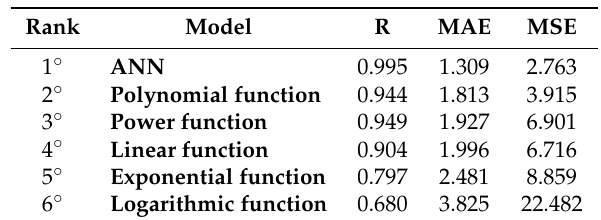
Table 8. Effective functions versus ANN for forecasting harvested area.